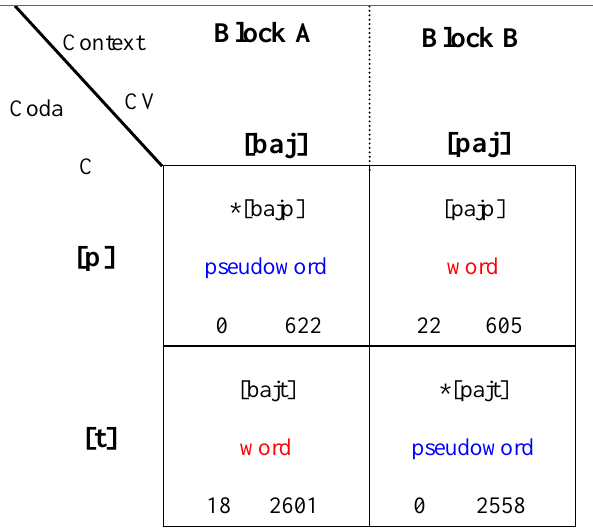
Table 1 | Orthogonal variation of acoustic-phonetic features and lexicality across blocks for the four critical items. Numbers indicate word (left) and trigram (right) frequency (per million) for that item (CELEX Lexical Database; Baayen et al.,